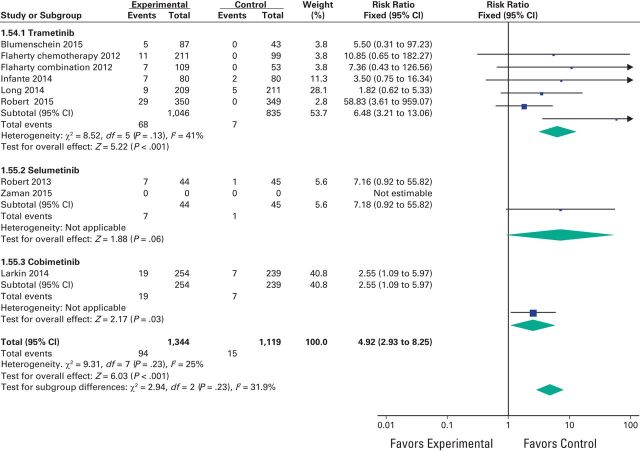
Forest plots of risk ratio of decreased ejection fraction associated with MEK inhibitors versus control.